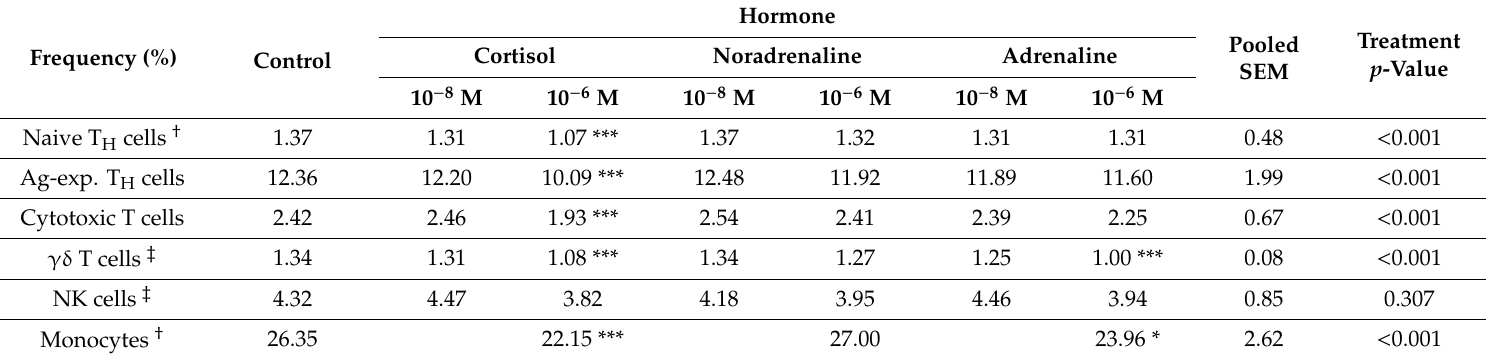
Hormone -ValueCortisol